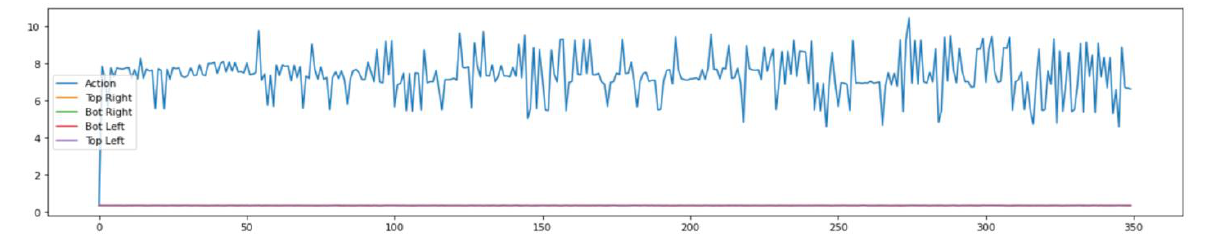
Figure 7. Frame-by-frame changes of the five regions of interest of a single embryo. The X axis represents the frame number, and the Y axis represents the standard deviation of the pixel change per frame. This graph represents a video with a single embryo. The blue line represents the “action” area which is the region of interest containing the embryo proper. The yellow line represents the top right corner region external to the embryo, the green line represents the top right corner region external to the embryo, the red line represents the bottom left corner region external to the embryo and the purple line represents the top left corner region external to the embryo.